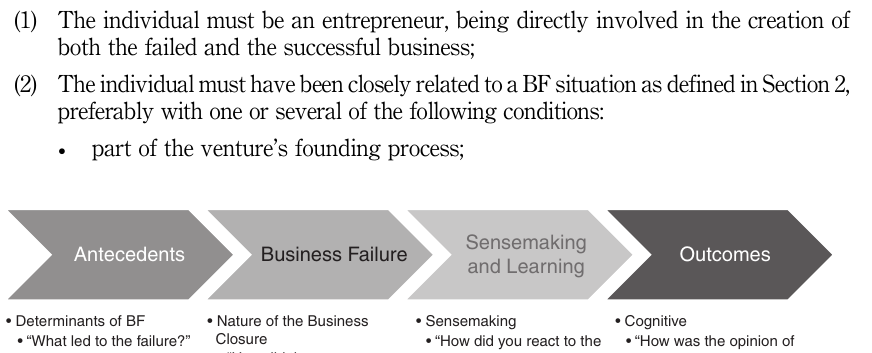
Figure 2. Operationalized framework for studying business failure (BF)